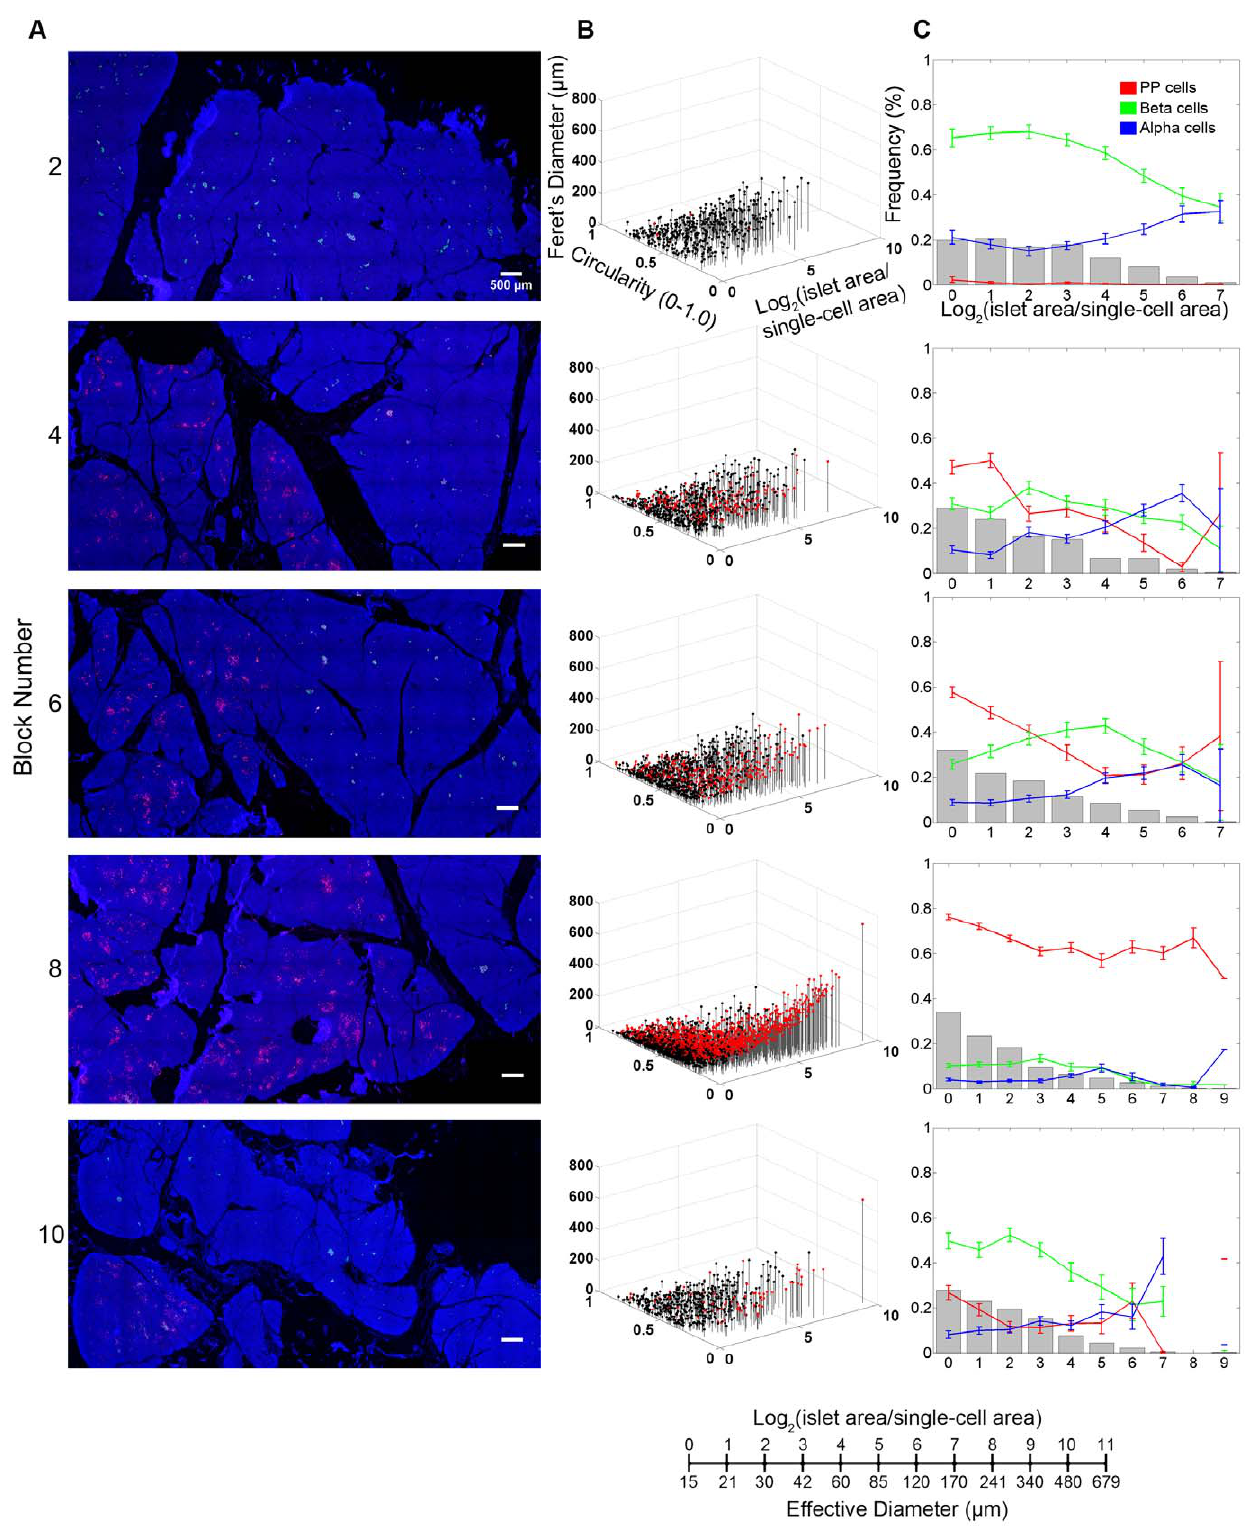
Figure 2. Detailed distribution of the PP-rich region in the head of the pancreas. A : Virtual slice views of blocks in the head region. Immunostained for PP (red), insulin (green), glucagon (white) and nuclei (blue). All in the same scale. B : 3D visualization of islet size (area) and shape (circularity and Feret’s diameter) distribution. Each dot represents a single islet/cluster. PP-cell containing clusters are shown in red. C : Quantitative analysis of individual islet size distribution and cellular composition. Relative frequency of islet size (gray bar) and ratios of beta (green), alpha (blue), and PP (red) cells within islets are plotted against islet size; means 6 SEM.